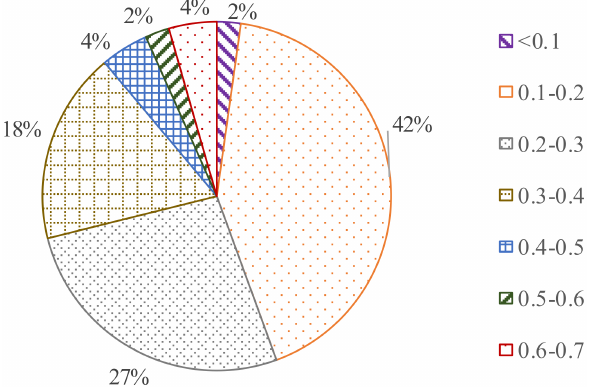
Figure 5. Frequency distribution of turbidity in